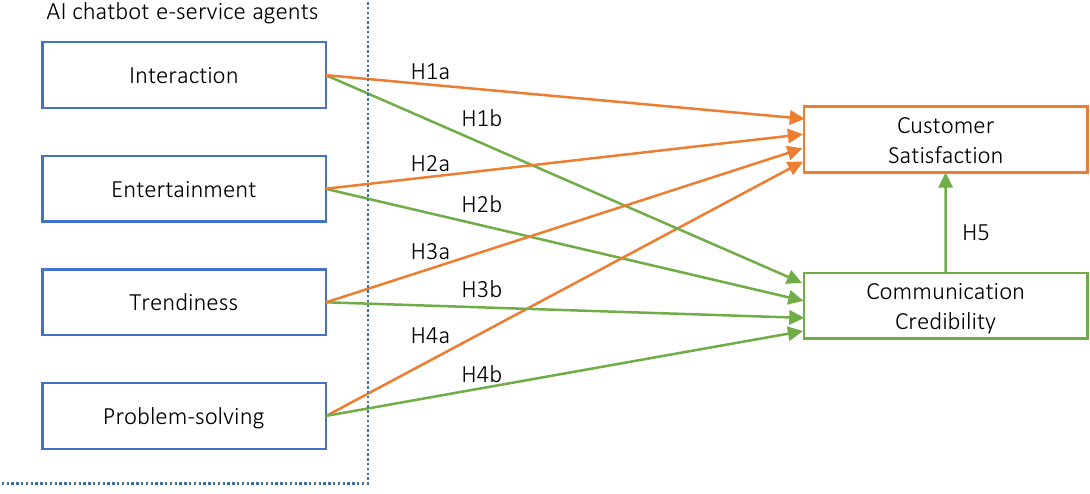
Figure 1. Conceptual